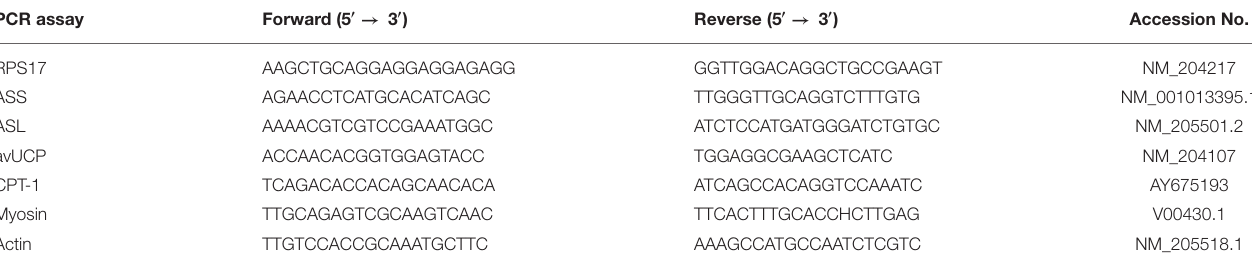
TABLE 1 | Primer sequences for real-time PCR in this study. PCR